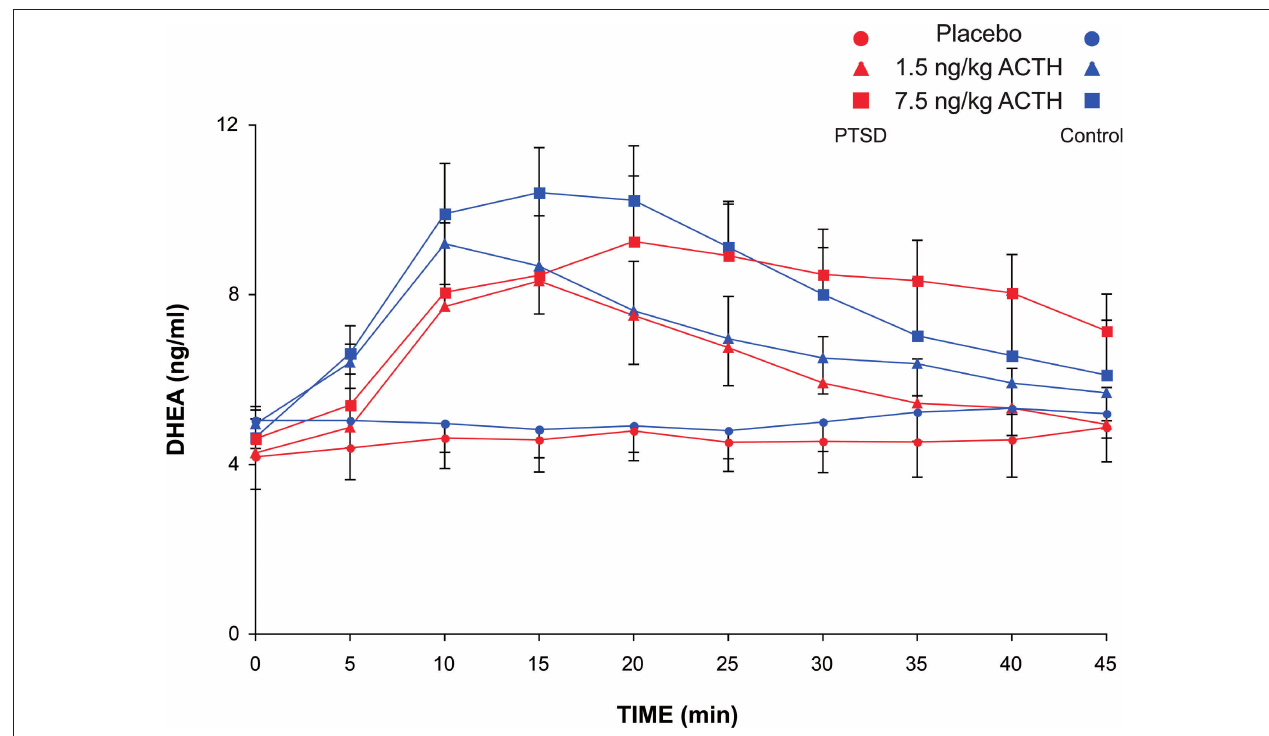
FIGURE 3 | Plasma DHEA concentration of PTSD and control subjects after ACTH infusion. Sampling occurred at 5-min intervals for 60 min and at 15-min intervals for the following 90 min. Mean and SEM values are plotted for each subject group and each dose of ACTH for the fi rst 45 min after